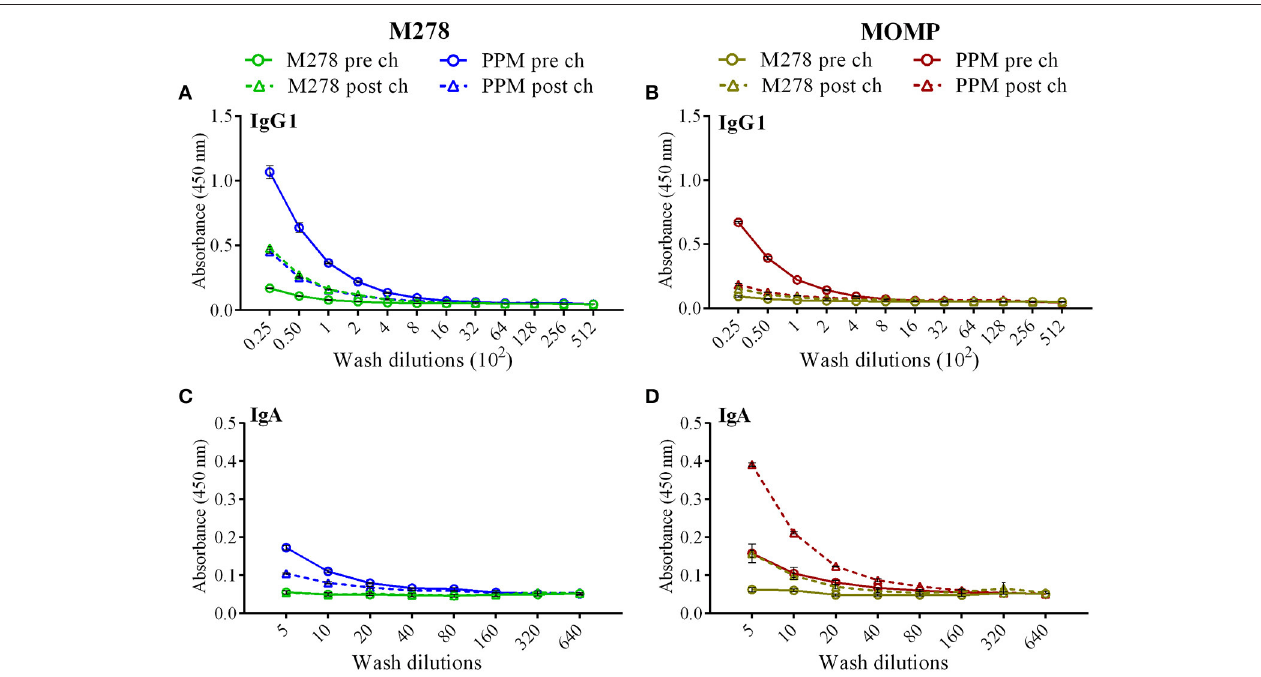
FIGURE 5 | Antigen-specific mucosal antibodies in cervico-vaginal washes from immunized mice. Mice were immunized with bare M278 and encapsulated-M278 (PPM) and challenged intravaginally with C. muridarum as described above. M278-specific IgG1 (A) , MOMP-specific IgG1 (B) , M278-specific IgA (C) and MOMP-specific IgA (D) antibodies were measured by ELISA in the pooled vaginal wash samples of immunized mice before (pre-challenge) and 3 weeks following a C. muridarum challenge infection (post-challenge). Vaginal wash samples were diluted at a two-fold serial dilution to determine the end-point antibody isotype titers and each data point represents the mean ± standard deviation of duplicate samples. M278 (bare M278 immunized group); PPM (PLA-PEG-M278 immunized group); pre ch (pre-challenge); post ch